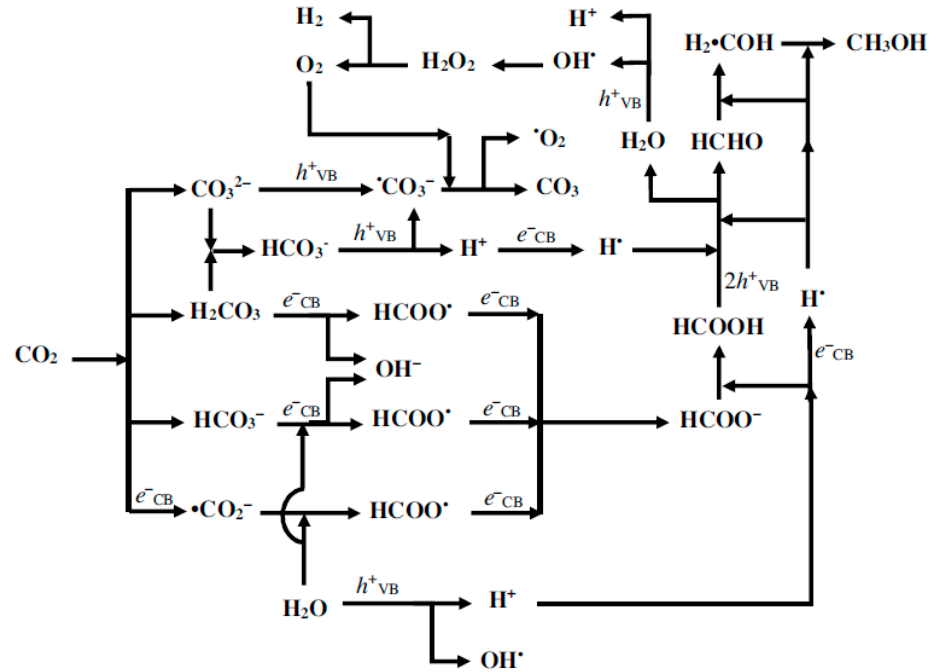
Figure 4. Aqueous phase photocatalysis of CO 2 and water: proposed reaction pathway. Reproduced from work in [39] . Copyright 2016 Elsevier Ltd.